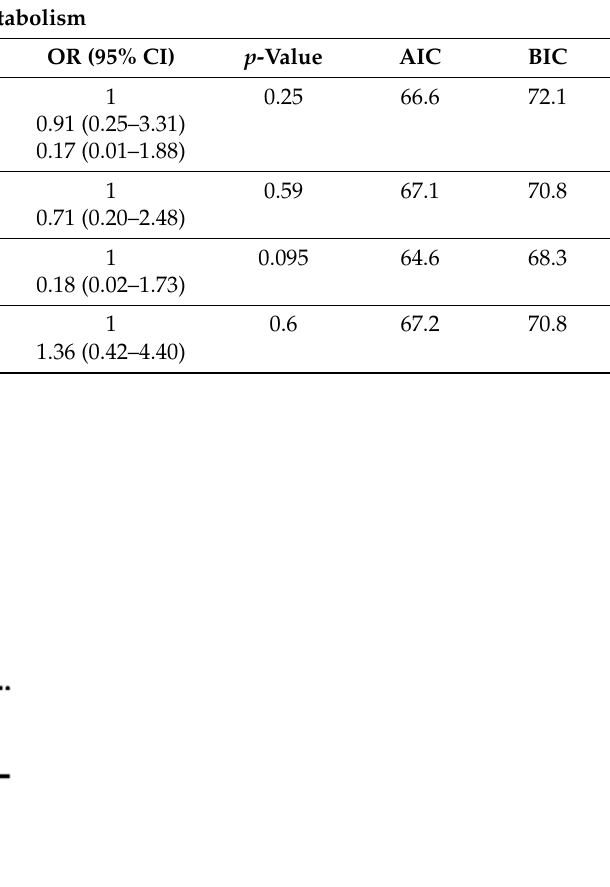
Figure 2. Total metabolite concentrations in urine depending on genotypes of SULT1A1_rs3760091 polymorphism. Bars in the box show the first quartile, the third quartile, and median and whisker charts represent the minimum to maximum